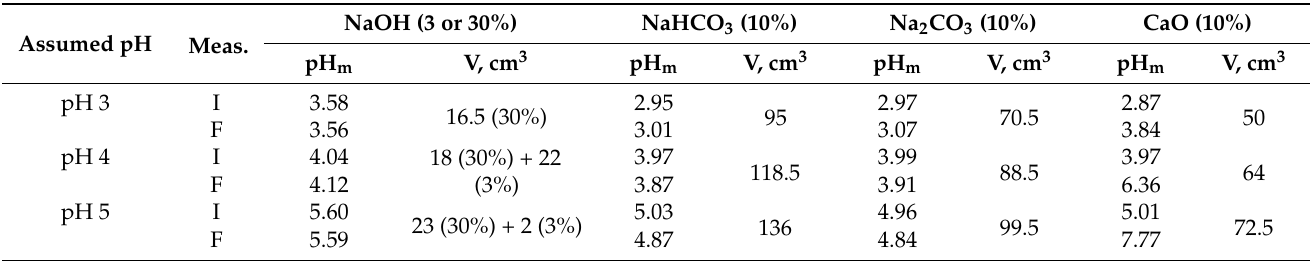
Table 9. pH after reaching the required value and after an hour, and the amount of solution added.